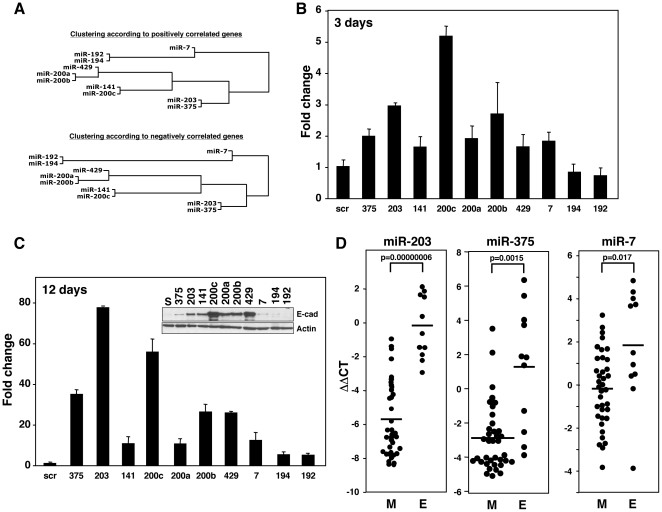
Validation of three predicted EMT-regulating miRNAs.(A) The EMT-related miRNA subcluster derived by using either positive (upper) or negative (lower) sPCC values as described in Figures 4 and S3. (B and C) Ability of miRNAs in the epithelial cluster to cause upregulation of E-cadherin in mesenchymal ACHN cells. ACHN cells were either transfected (B) once or (C) 3 times with the indicated miRNAs, and after (B) 3 days and (C) 12 days respectively, the expression of E-cadherin mRNA was quantified by real-time PCR. The Western blot inserted in C confirmed that the upregulation of E-cadherin mRNA also resulted in a induction of E-cadherin protein. (D) Comparison of the expression of the three new EMT-regulating miRNAs between the epithelial (E) and mesenchymal (M) cell lines among the NCI60 cells recently described [11].